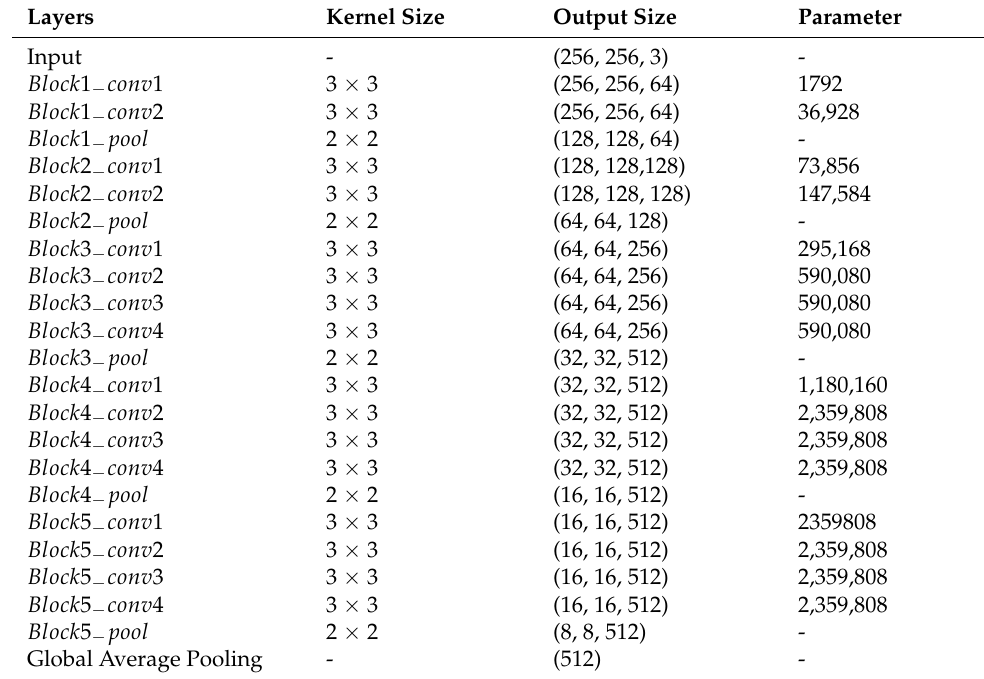
Table 1. Related parameter and output size of original VGG19